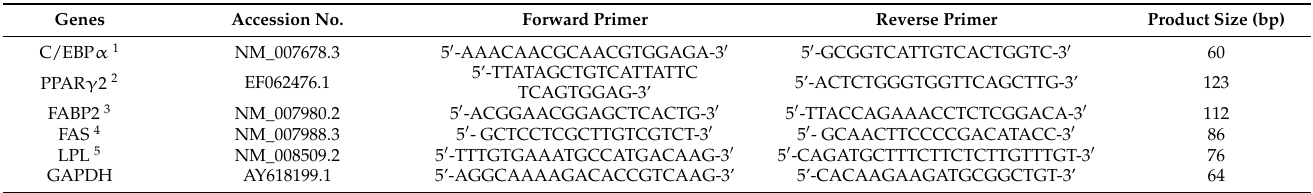
Table 1. Primer sequences and lengths of amplified templates for reverse transcription-quantitative polymerase chain reaction